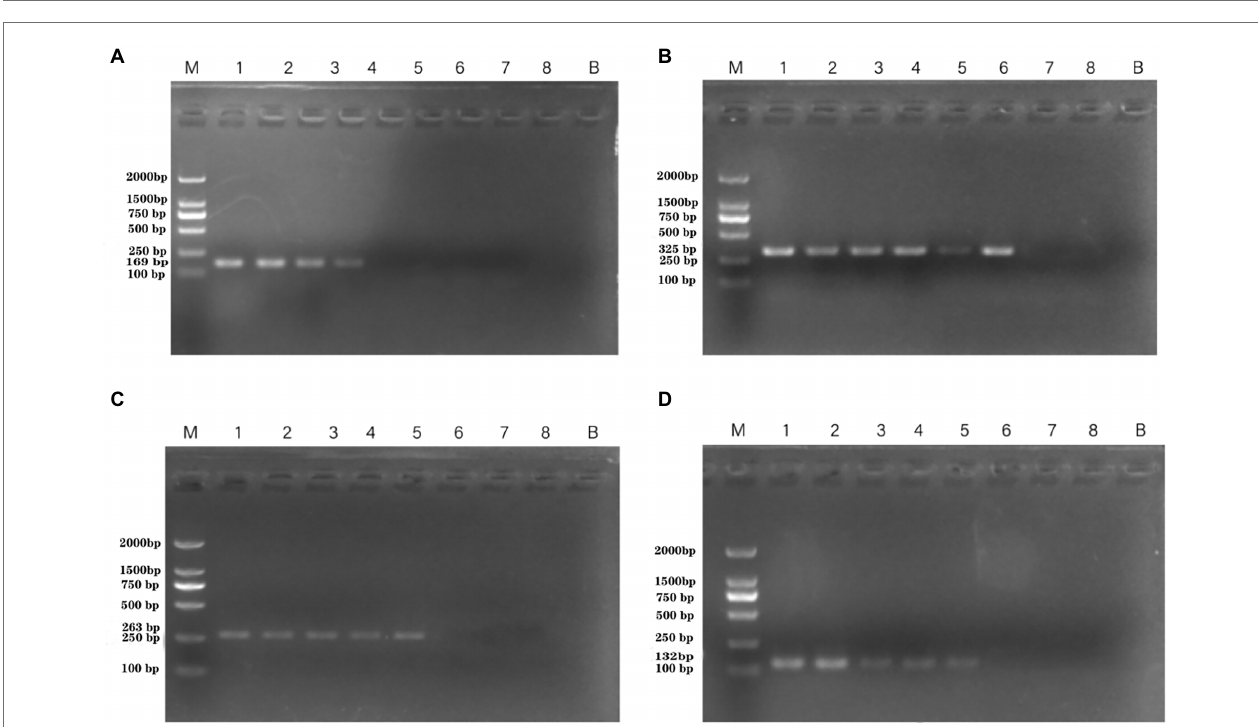
FIGURE 2 | PCR detection sensitivity using dilutions of genomic DNA from Pseudomonas aeruginosa ATCC 15442. Lane M = DSTM 2000 marker (Dongsheng Biotechnology, Guangdong, China); lane N = negative control (double-distilled H 2 O); lanes 1–8 = 65.4 ng/ μ l, 6.54 ng/ μ l, 654 pg/ μ l, 65.4 pg/ μ l, 6.54 pg/ μ l, 654 fg/ μ l, and 65.4 fg/ μ l, 6.54 fg/ μ l, respectively. (A) Primer set PA1 (169 bp); (B) primer set PA2 (325 bp); (C) primer set PA3 (263 bp); and (D) primer set PA4 (132